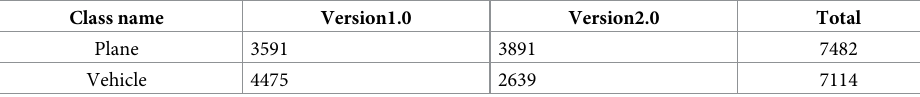
Table 4. UCAS-AOD dataset categories information.